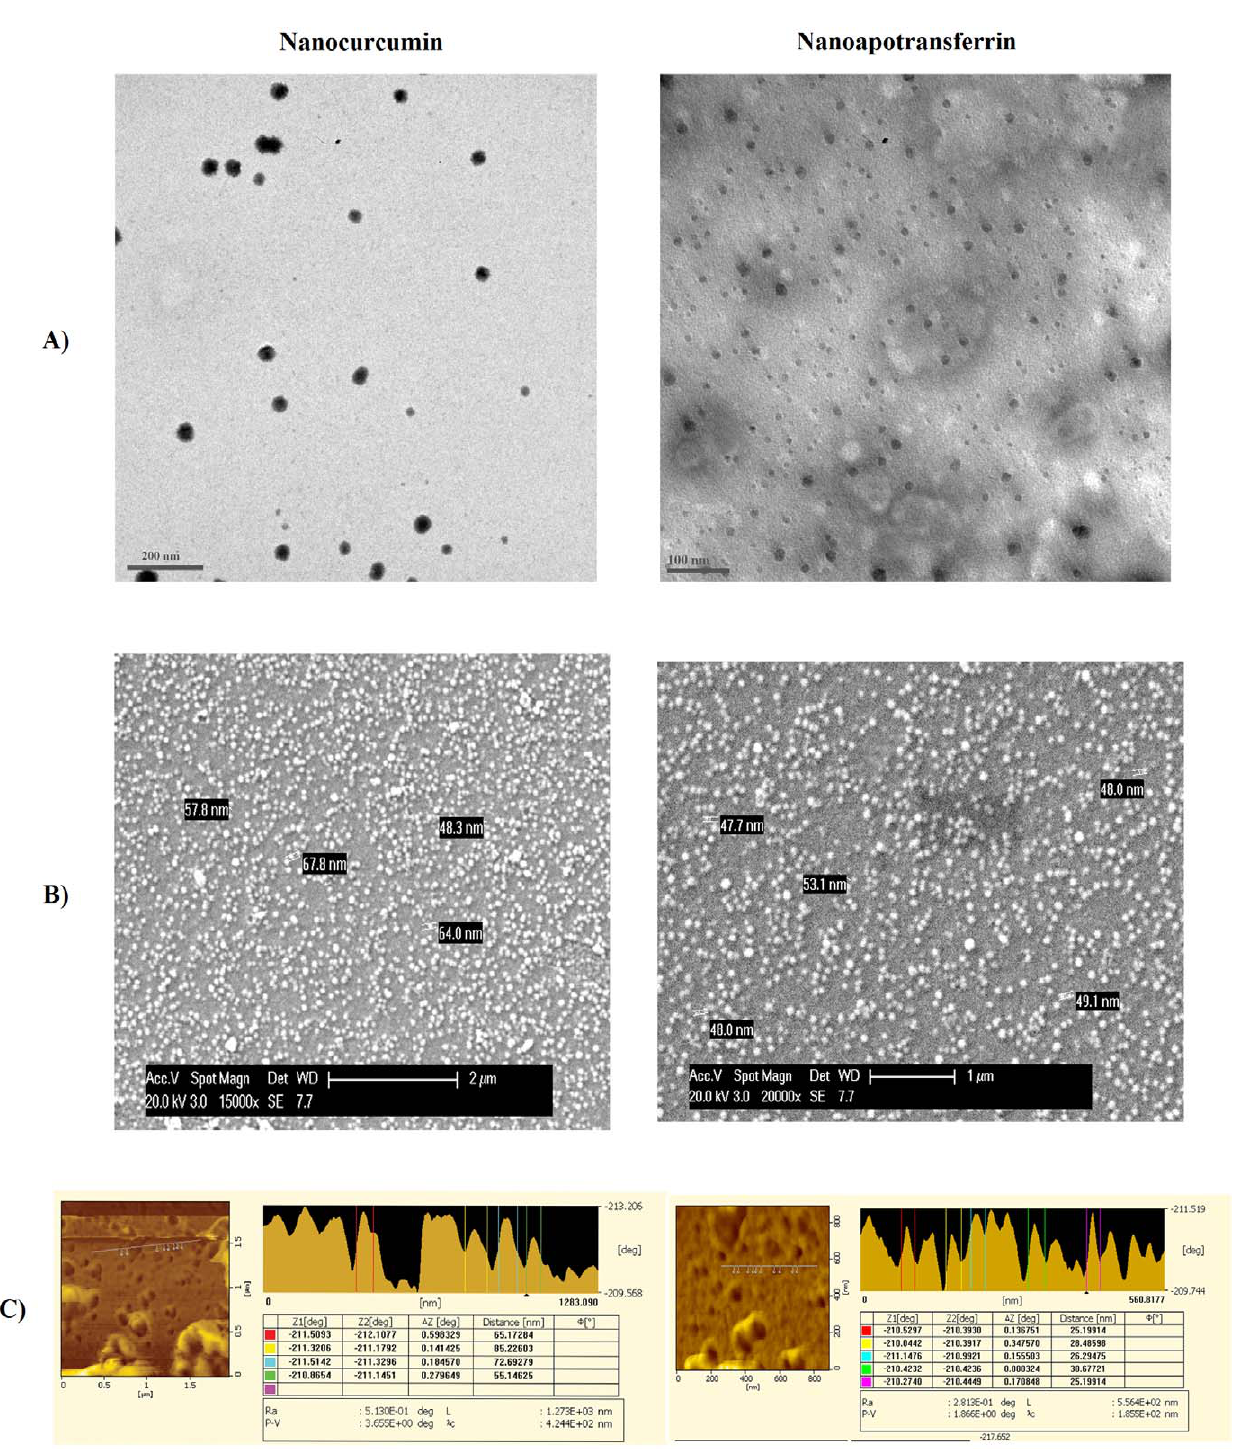
Figure 1. Curcumin loading increases size of apotransferrin nanoparticles. The preparations of curcumin-loaded apotransferrin nanoparticles (nano-curcumin; left) and apotransferrin nanoparticles without curcumin (nano-apotransferrin; right) were examined by A) TEM B) SEM and C) AFM as indicated. doi:10.1371/journal.pone.0023388.g001 controls. Semi-quantitative and real-time PCR of topoisomerase II a expression demonstrated that this gene was upregulated on HIV infection but was prominently down-regulated by nano-curcumin treatment (Fig. 7A). This down-regulation was not observed when the